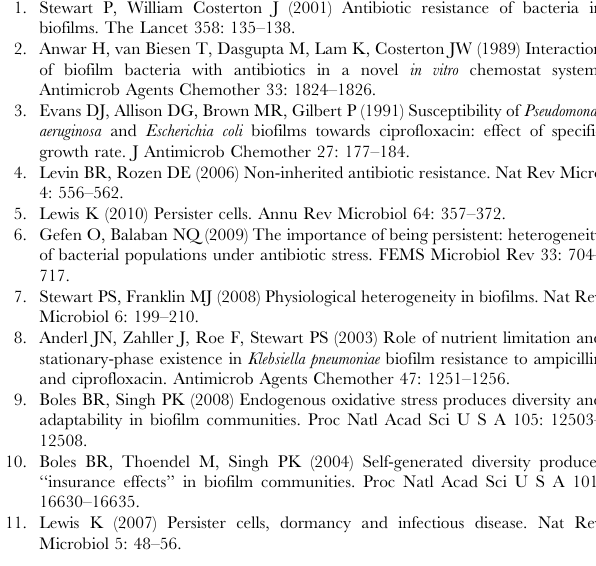
Figure S6 Toxin-antitoxin modules do not contribute to biofilm- associated increased ofloxacin tolerance upon leucine starvation.